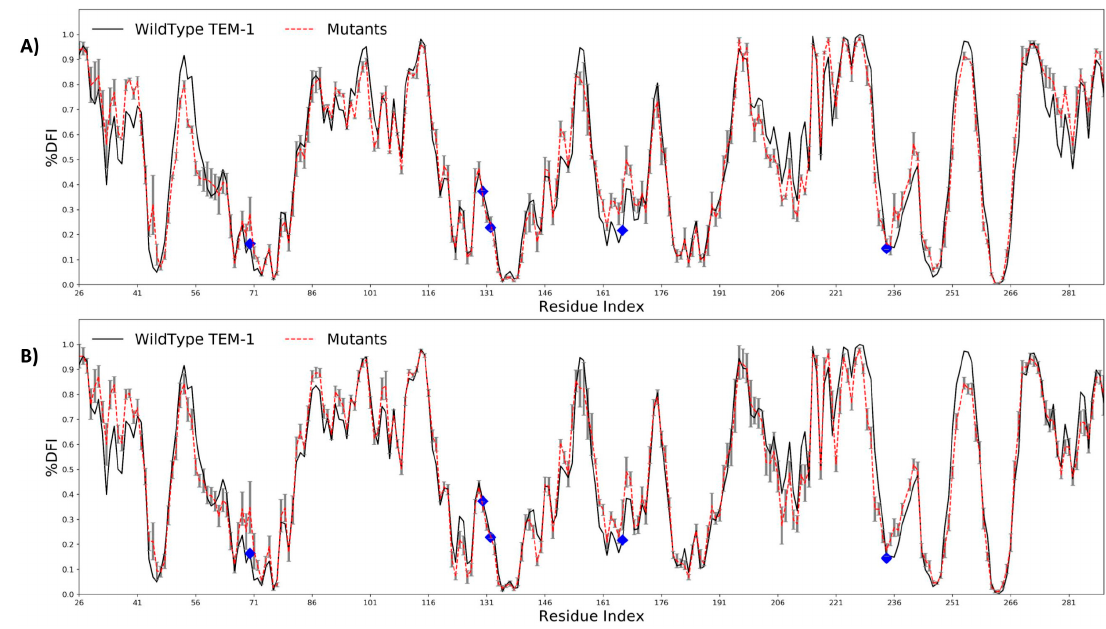
Figure 2. The difference in the conformational dynamics of the wildtype TEM-1 β -lactamase (black) with the average %DFI profile (y-axis) of the single point variants (red), distal from the catalytic region (blue diamonds). We found that the mutants, despite being distal to the active region (Figure 1) impacted the dynamics of the active sites, particularly S70 and E166. This behavior was observed in the single point variants providing resistance to β -lactam antibiotics ( A ) as well as in the mutants impacting the resistance through inhibitors ( B ).